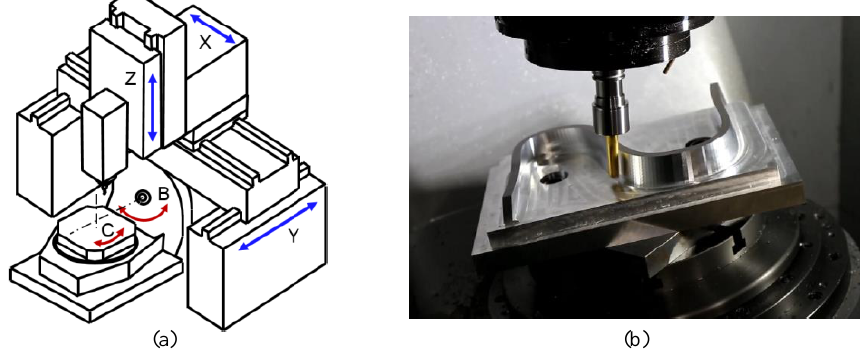
Figure 3. Experimental method for the S-shaped machining test: ( a ) Structural configuration of five-axis machining center employed in this study; ( b ) Machining set-up of the S-shaped workpiece.